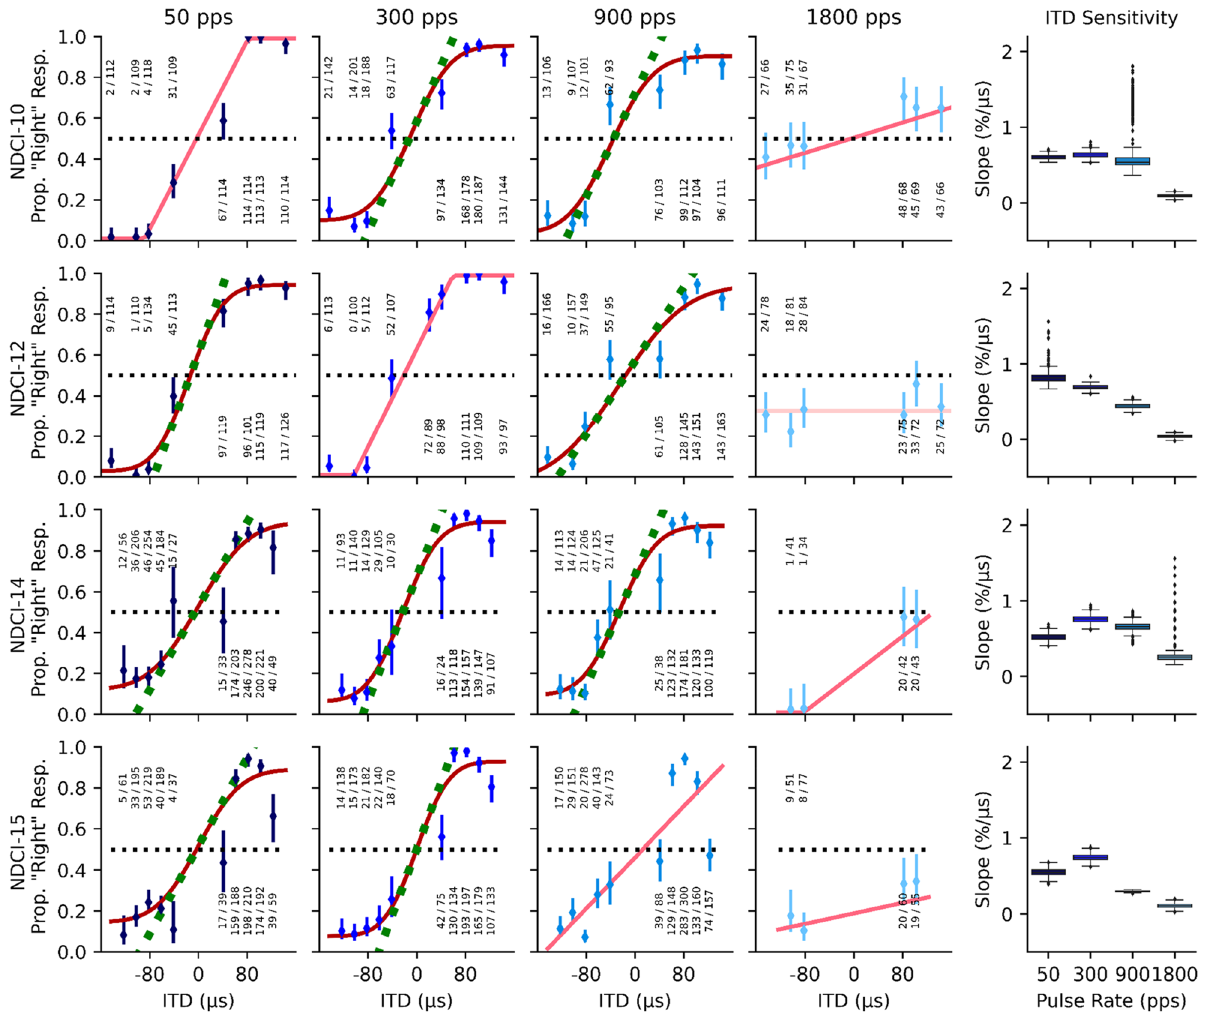
Figure 2. Example psychometric curves for four neonatally deafened, cochlear implanted (NDCI) rats localizing rectangular windowed pulse trains by interaural time difference (ITD). The first four columns represent a different pulse rate from left to right 50, 300, 900, and 1800 pulses per second (pps), each indicated with a different shade of blue. The y-coordinates reflect the proportion of trials during which the animal responded on the “right” hand spout (Prop. “Right” Resp.). The x-axis shows the tested ITD values from − 150 to + 150 µs. Negative ITD values indicate left ear leading ITDs. Annotations above or below each marker indicate the number of trials the animal chose the right hand side spout over the total number of trials for the given ITD value on the x-axis. Dark red curves show sigmoidal fits to the responses, bright red lines are linear fits with bounds, light pink are null model psychometric curve fits (see “Data analysis” in the Methods section for details on the model fits). Green dashed lines show the slopes of psychometric curves at ITD = 0 µs. The slopes serve to quantify the behavioral sensitivity of the animal to ITDs. The fifth column summarizes the ITD sensitivity across the different pps per animal as a function of slope. Each row shows the responses for a given animal. Psychometrics of all CI animals are shown in Fig.